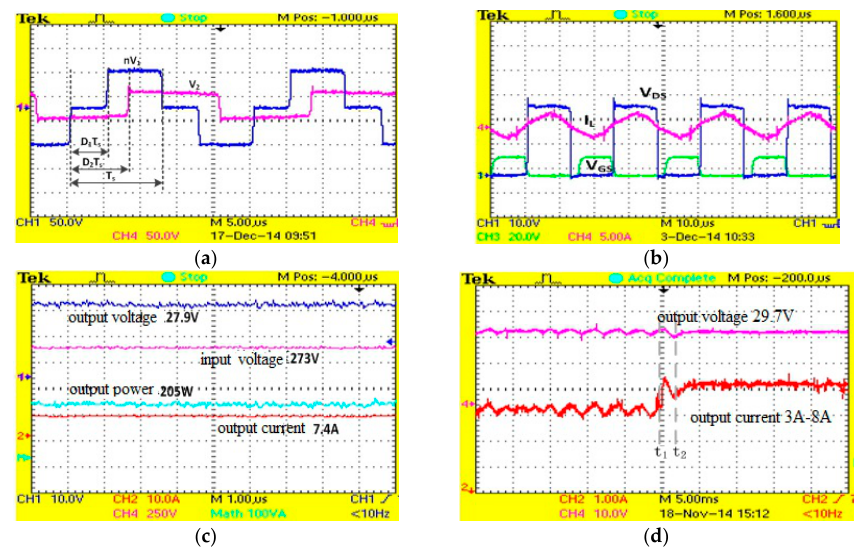
Figure 19. ( a ) The steady state waveform of input and output voltage; ( b ) The MOSFET gate driving signal and inductor current waveform; ( c ) Output characteristic waveform of power and voltage; ( d ) The transient waveform of output voltage under load variation.